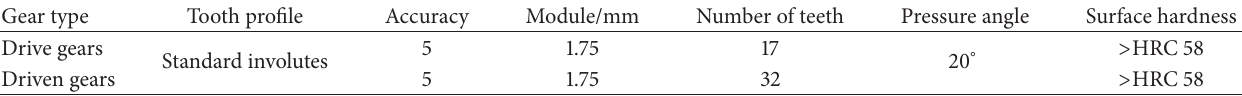
Table 2: Gear specification.